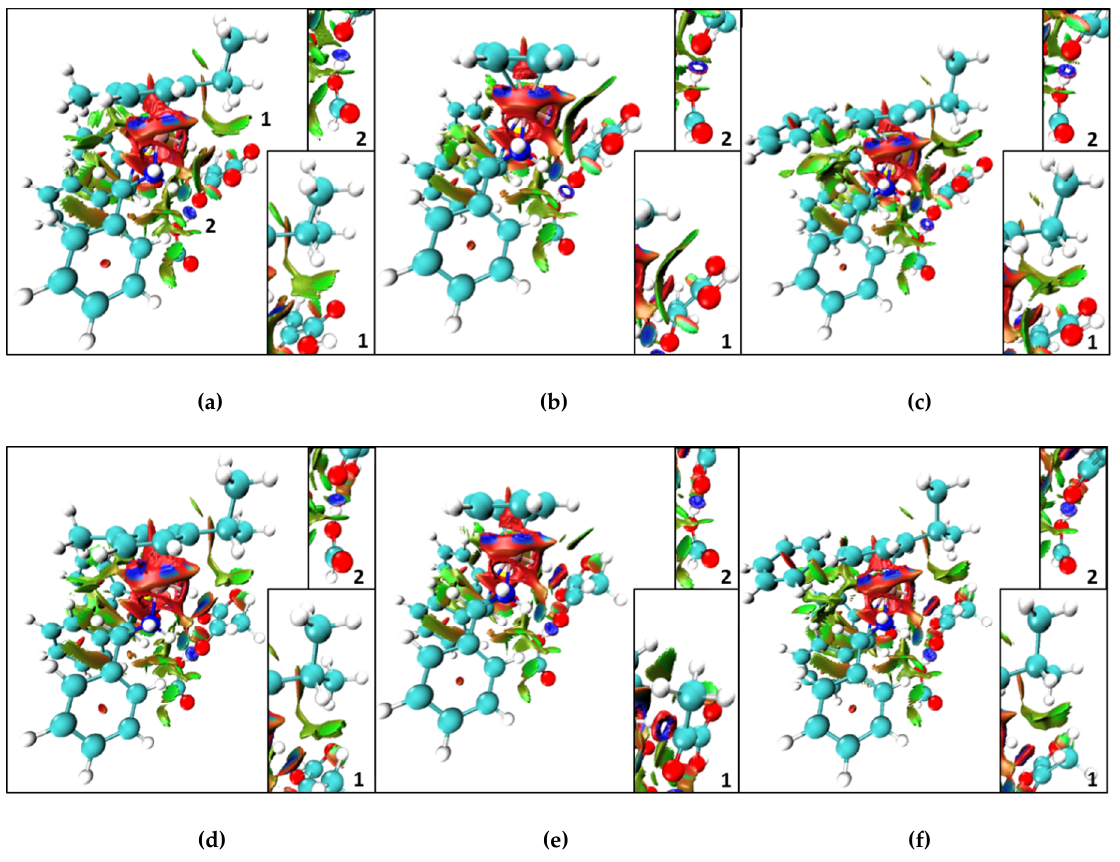
Figure 3. NCI plots for transition states ( a ) TS 2,3- R , ( b ) TS 2,3e- R , ( c ) TS 2,3g- R , ( d ) TS 2,3- S , ( e ) TS 2,3e- S , and ( f ) TS 2,3g- S . The important stabilizing interactions are marked with numbers and highlighted in the box with a zoomed-in view. Color code: red, repulsive; green, weak attractive; blue, attractive.